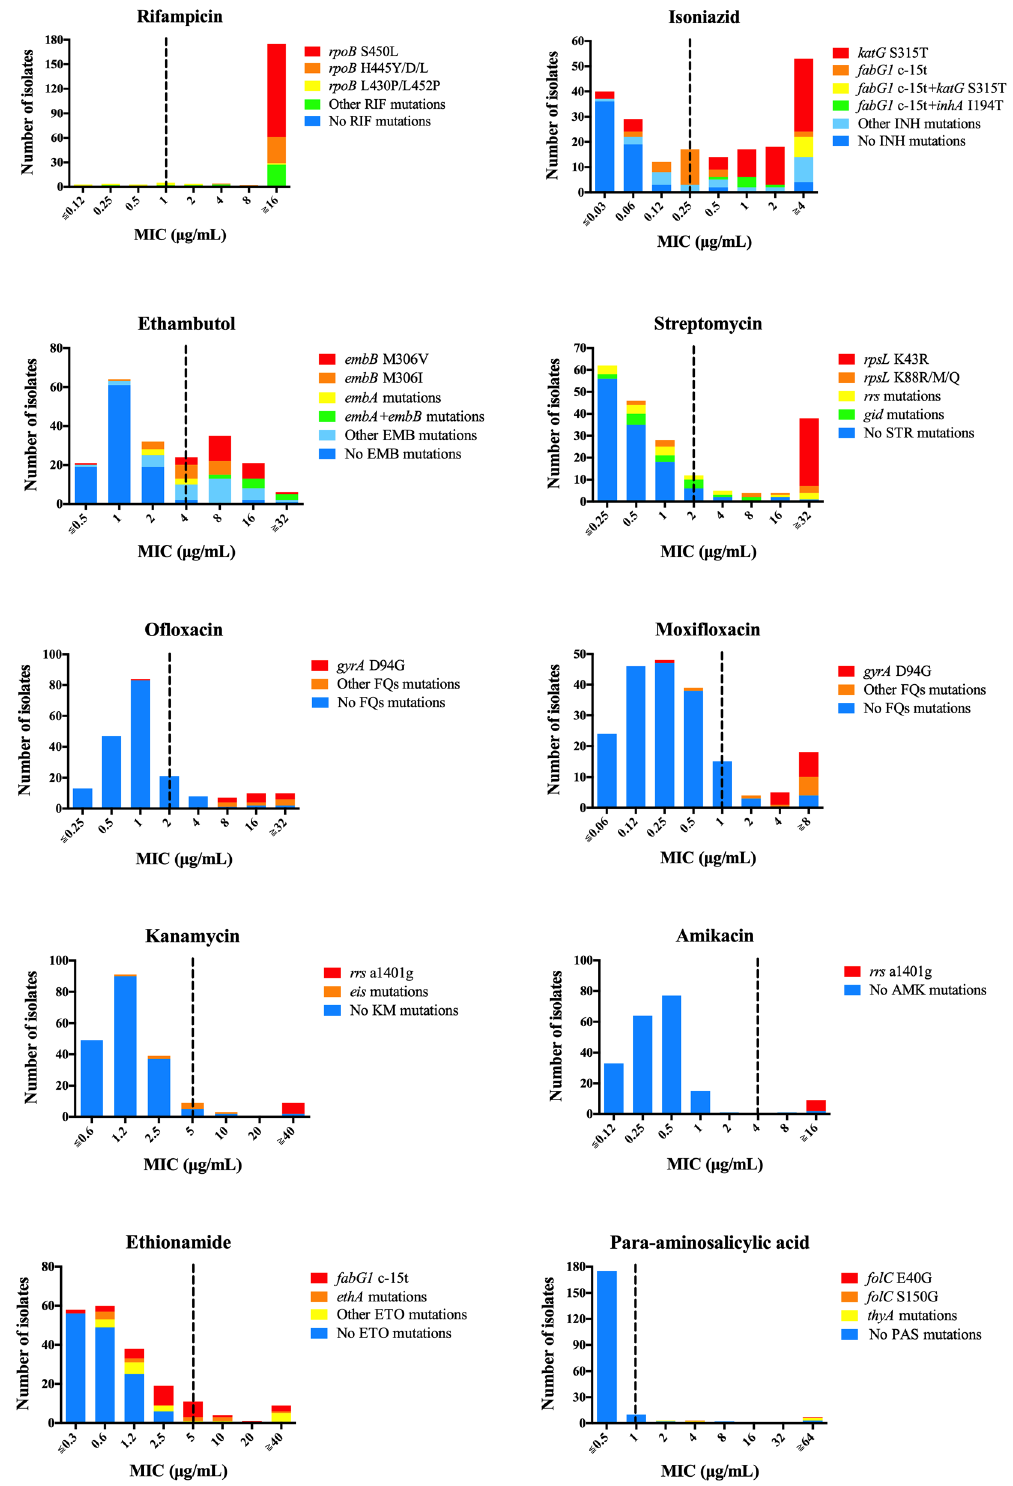
Figure 2. Distribution of drug resistance-associated mutations with corresponding MICs. Each stacked column represents a collection of isolates colored according to their genetic background. The x-axes show the MICs in μg/mL. The dashed lines indicates the critical concentrations used for MYCOTB